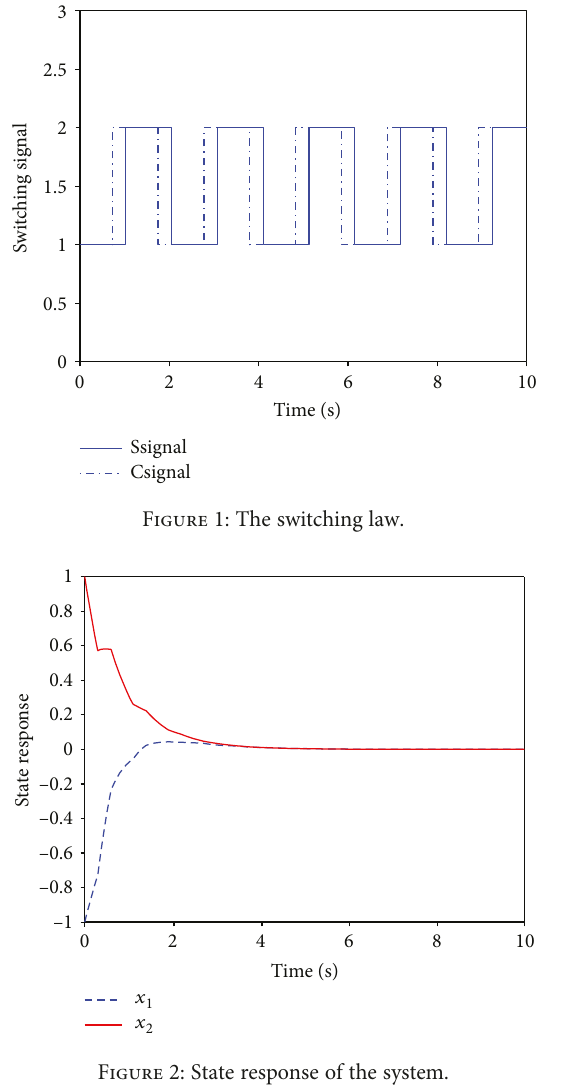
Figure 3: The switching law.